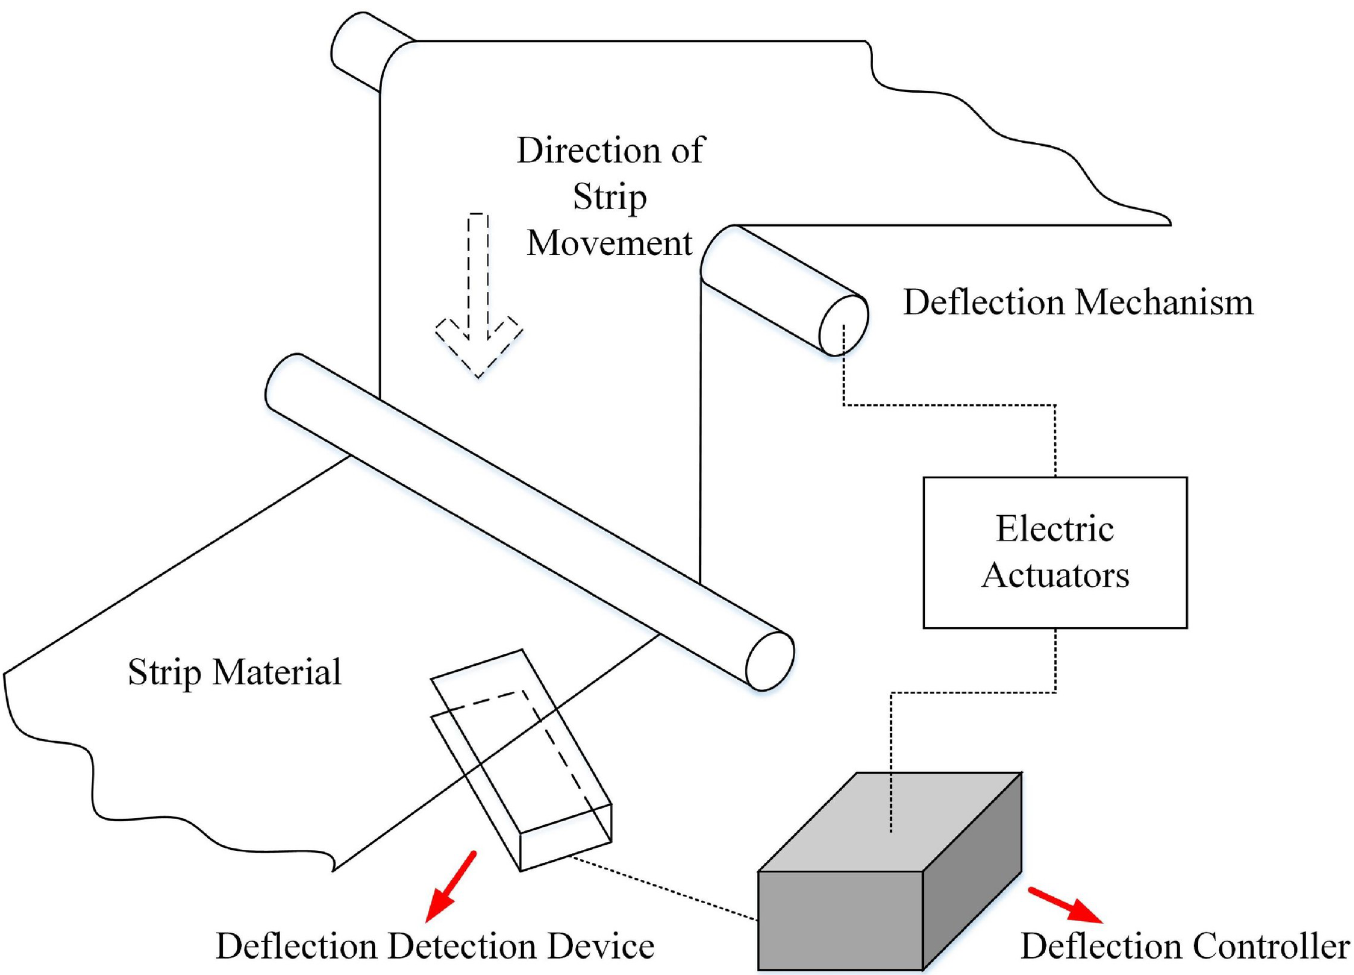
Fig 7. Structure diagram of correction